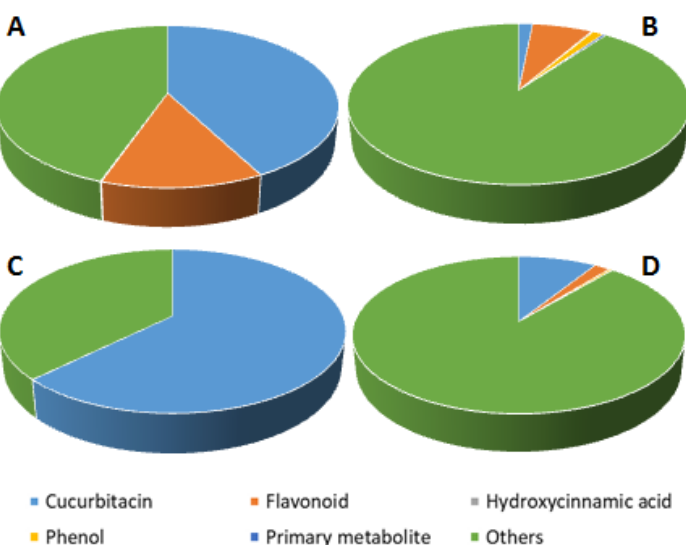
Figure 4. Main metabolite classes detected in C. colocynthis extracts. Cake graphs represent the percentages with respect to the total LC-MS signal of the different metabolite classes in: ethanol-extracted seed tegument (Teg-EtOH, ( A ), ethanol-extracted plantlets from in vitro cultures (PL-EtOH, ( B ); adult leaves extracted in chloroform (Leaf-CHL, ( C )); chloroform-extracted plantlets from in vitro cultures (PL-CHL, ( D )).